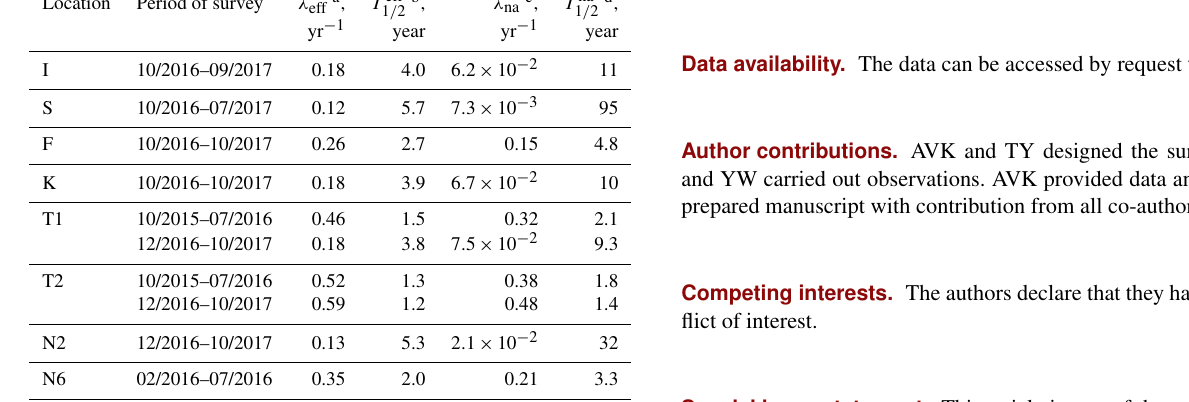
Table 2. Characteristics of γ dose equivalent rate attenuation for the sites under study. The date format is month/year.